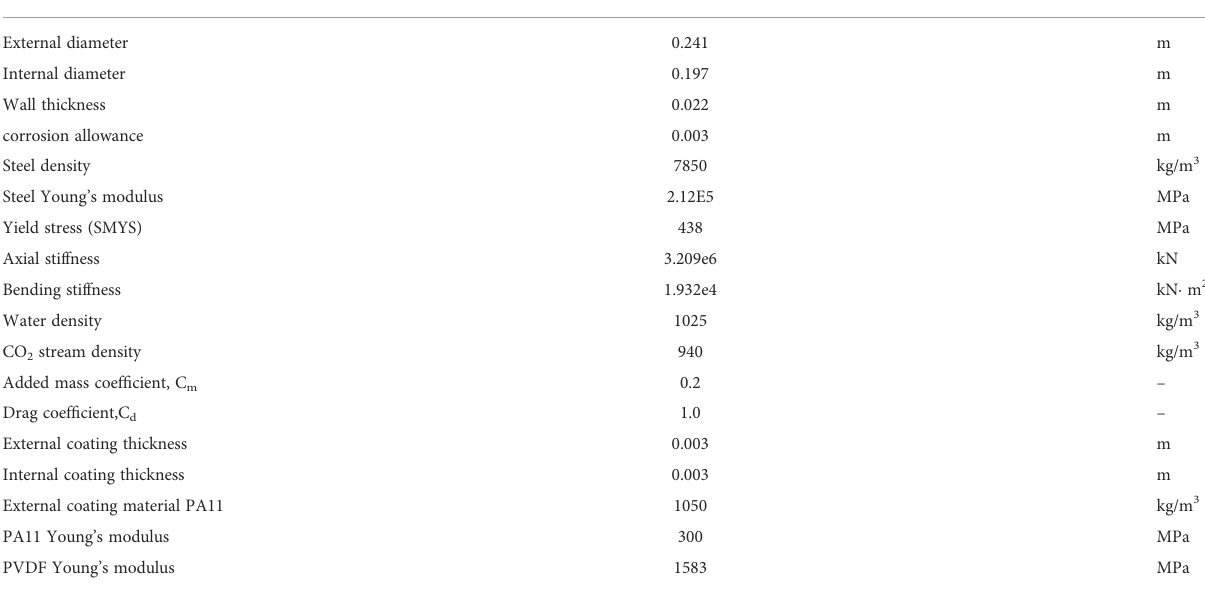
TABLE 1 Main parameters of steel catenary riser (SCR).